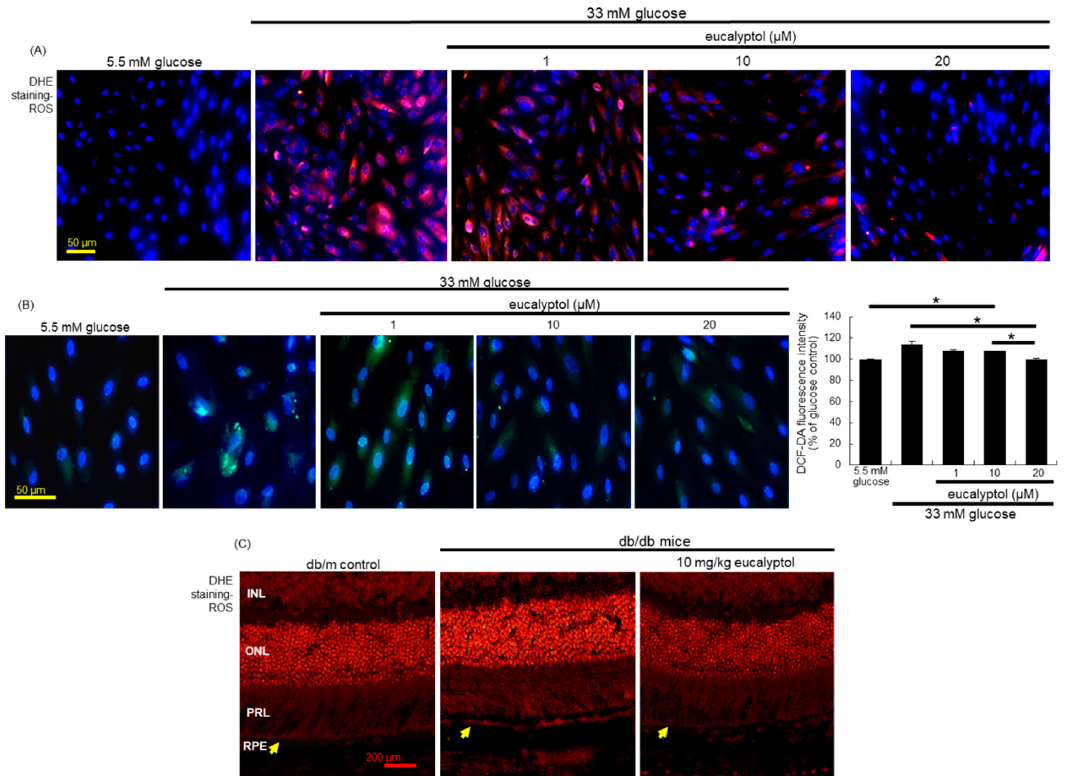
Figure 5. Inhibition of ROS production by eucalyptol in RPE cells ( A and B ) and in retina ( C ). For the measurement of ROS production, the DHE staining was conducted in RPE cells ( A ) and in retina ( C ). INL, inner nuclear layer; ONL, outer nuclear layer; PRL, photo receptor layer; RPE, retinal pigment epithelium monolayer. The yellow arrows indicate RPE layer. Furthermore, the DCF-DA staining for ROS production ( B ) were carried out in eucalyptol-treated RPE cells, and the DCF staining intensity (mean ± SEM, n = 3) was measured. Nuclear staining was done with 4 ′ ,6-diamidino-2-phenylindole. DHE- or DCF-stained RPE cells or retina were visualized under fluorescent microscopy. Scale bars: 50–200 μ m. * Bar graph values indicate a significant difference at p < 0.05.